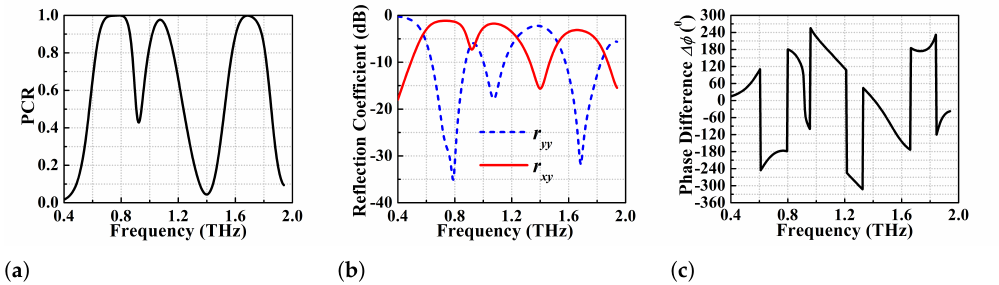
Figure 14. Performance analysis of the triple band PC ( a ) PCR ( b ) co-pol ( r yy ) and cross-pol ( r xy ) reflection coefficients ( c ) phase difference between r u and r v .